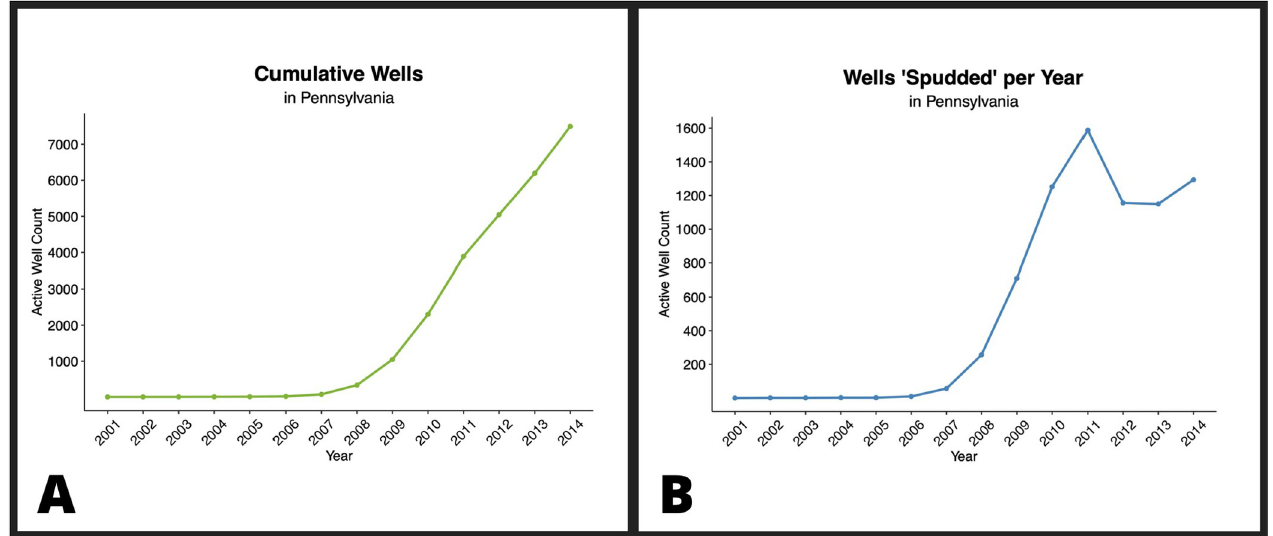
Fig 1. Line graphs of UNGD in Pennsylvania over time. Panel A shows the number of active wells that have been drilled over time as determined through each well’s corresponding spud date (defined as the date well drilling commenced or date the largest pipe casing for the well was installed). Panel B shows the number of active wells that have been drilled each calendar year as determined through each well’s corresponding spud